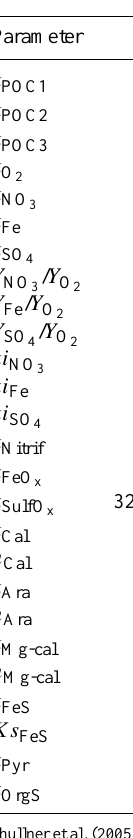
sorbed-P, sorbed-NH + , sorbed-Fe(II) and iron(III)-sorbed-P 4 are treated as solid-bound constituents in equilibrium with the pore water phase. Finally, refractory organic matter, which is not otherwise modeled, is assumed to react with sul- fide during the process of sulfurization